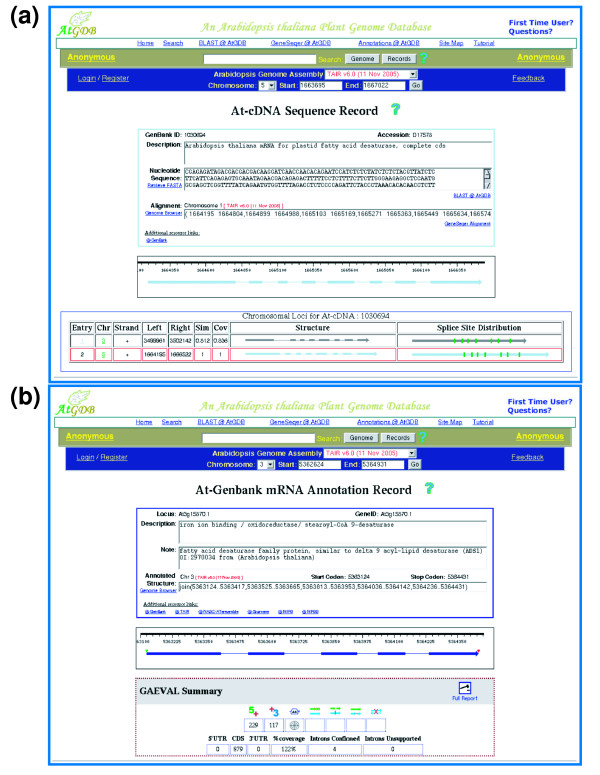
Individual feature pages found at AtGDB. (a) An AtGDB record page summarizing the GeneSeqer spliced alignment of an Arabidopsis thaliana cDNA sequence (accession BT020201, GenBank id 55733740). Feature structure glyphs found in the alignment loci summary table at the bottom of the window are as described in Figure 1. Green bars in the splice site distribution glyph represent the location of slice junctions in the processed mRNA transcript. (b) An AtGDB annotation record page detailing an Arabidopsis gene annotation (At3g15870.1). The GAEVAL Summary report at the bottom of the window displays information obtained using the integrated GAEVALxGDB services.